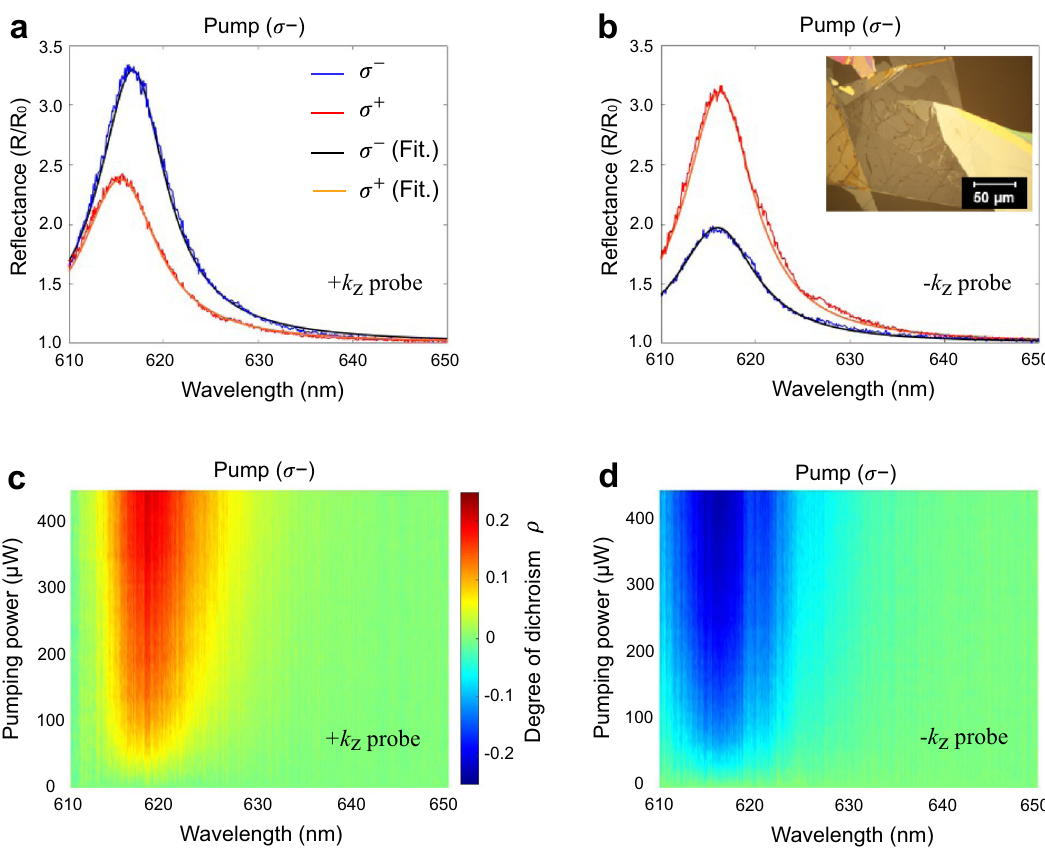
Fig. 2 Experimental demonstration of photoinduced nonreciprocal circular dichroism in WS 2 . a , b show cases of σ + and σ − probes spectral re fl ectivity, under wavevector inversion geometry (for k = k z and k = − k z cases), for the σ − pump incidence. Solid lines show the result of fi tting by a modi fi ed Fresnel equation with surface conductivity described by a Lorentzian model (see Methods for details). Inset shows the optical microscope image of an encapsulated WS 2 monolayer on a glass substrate. c , d show pump power dependent dichroic response as seen in re fl ectivity from the sample (see Eq. 4) for probes coming from opposite directions. Here 600 nm σ − pump is incident as in positive k z direction (as shown in Fig. 1). The results for the σ + pump can be found in the Supplementary Note